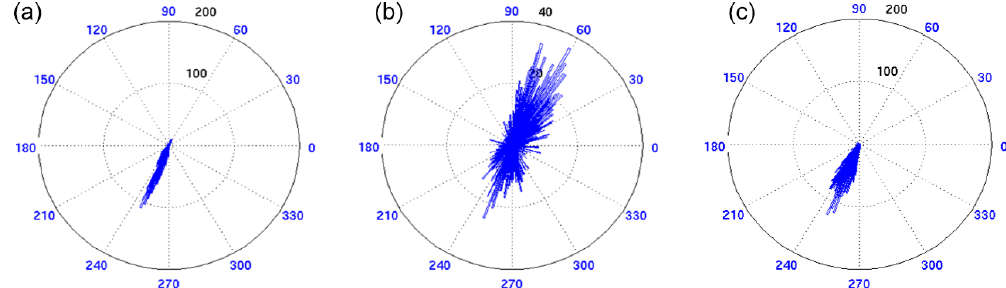
Figure 17. Ocean current roses of the (a) 30d low-pass-filtered ADCP observations, (b) Copernicus GlobCurrent based on MDT CNES- CLS13 and (c) Copernicus GlobCurrent based on MDT CNES-CLS18. The numbers in blue indicate the angle of the ocean current direction (0 ◦ is eastward, 90 ◦ is northward). The numbers in black and the concentric circles give the number of occurrences in the observations for each angle. Note that for the middle plot, the scale is different regarding the occurrences.